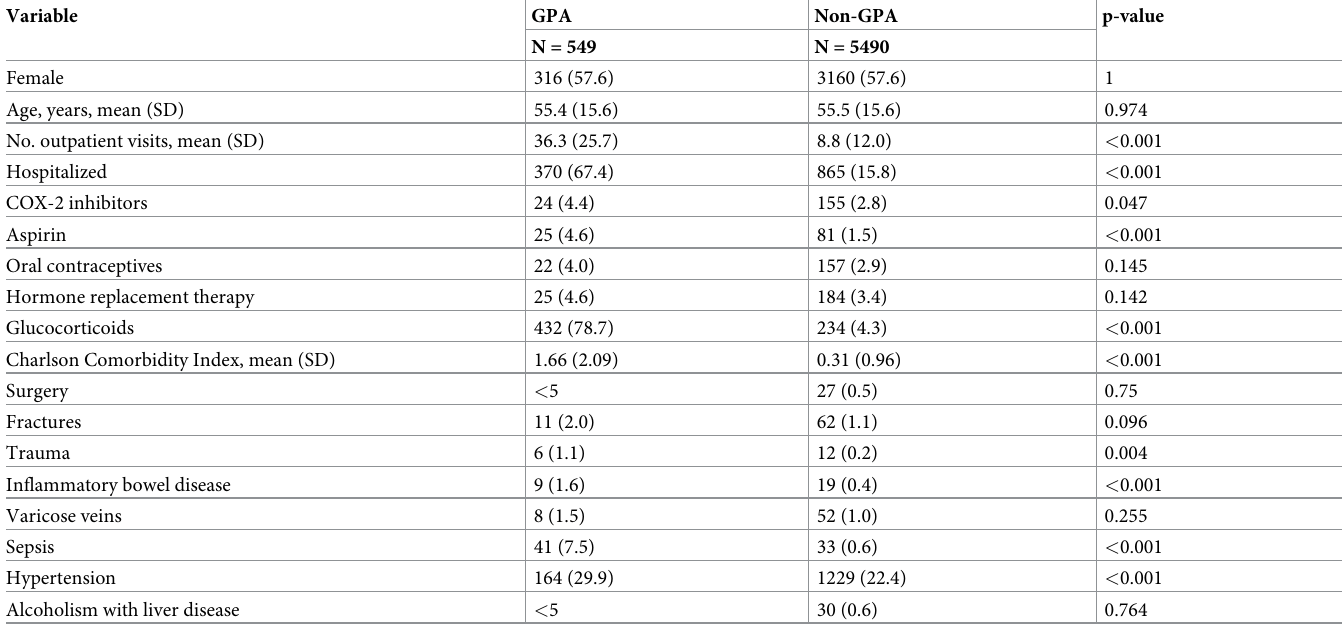
Table 1. Characteristics of GPA and comparison cohorts at